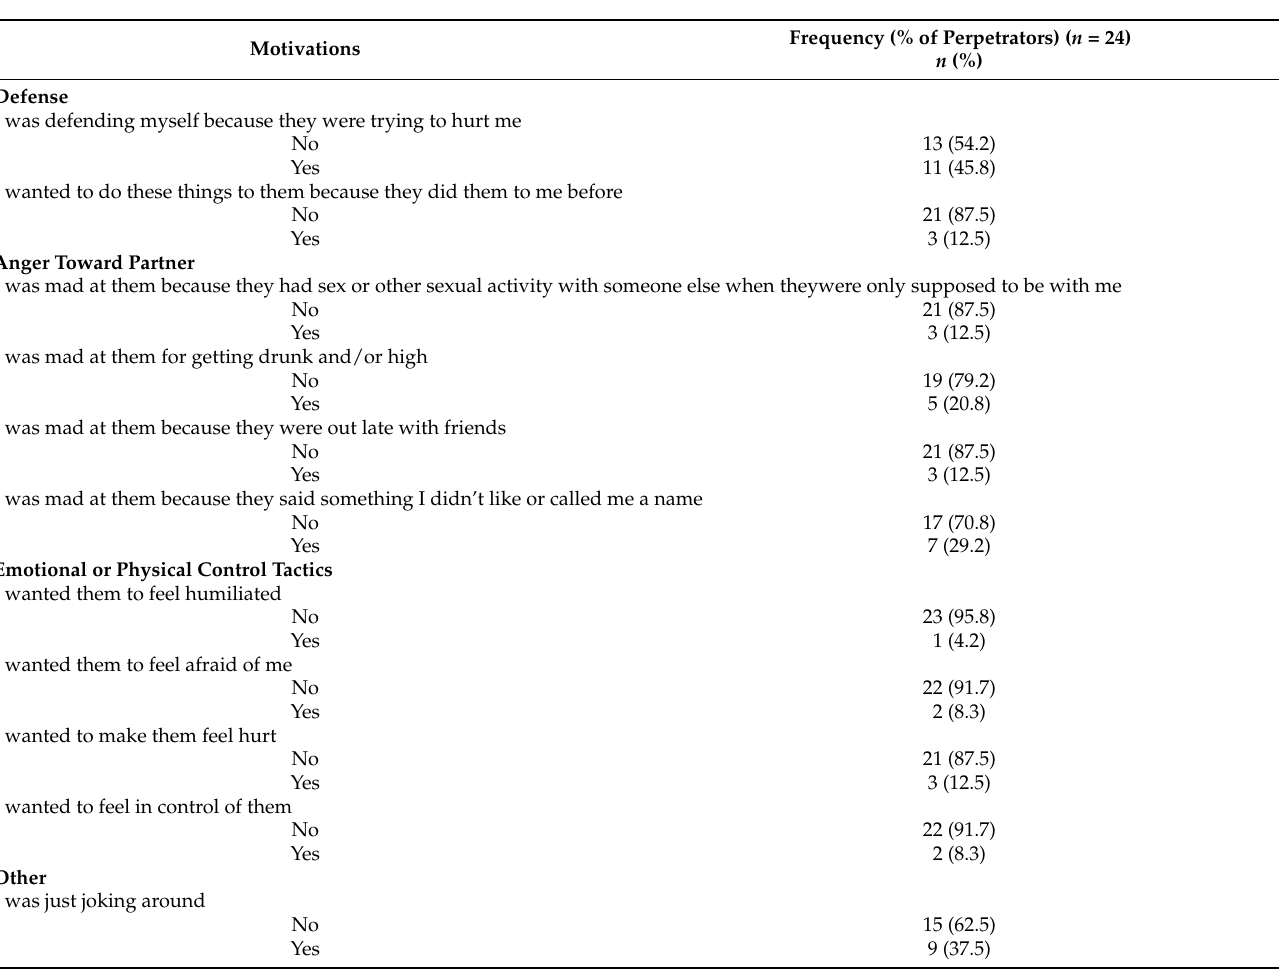
Table 2. Frequencies of Responses to Motivations for Perpetration of Violence.